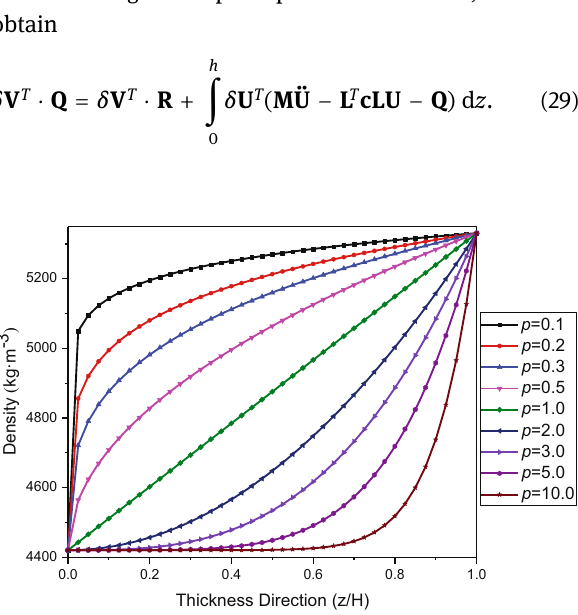
Figure 3: Density of functionally graded plates varies with gradient